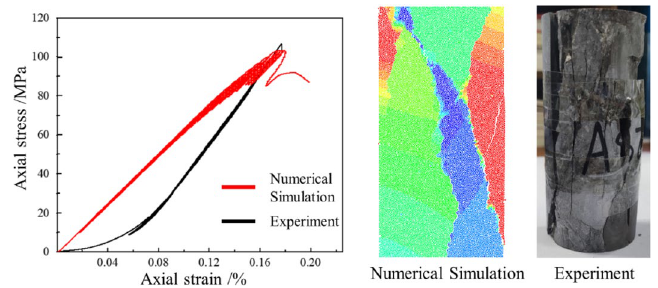
Figure 6. Simulation and Experiment results under uniaxial